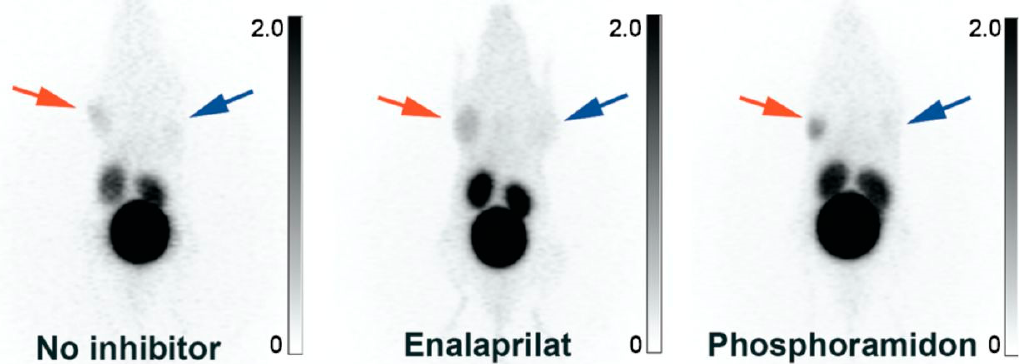
Figure 7. B1R positron emission tomography imaging. Maximum intensity projection PET images obtained with 68 Ga-P03083 without ( left ), with enalaprilat ( middle ), and with co-injection of phosphoramidon ( right ). The B1R + tumor (red arrow) was located on the right shoulder (the animal is viewed on a coronal projection, ventral viewpoint). The B1R − tumor (blue arrow) had no significant uptake. The gray scale bar to the right of each image is set in units of %ID / g. Figure reproduced from Lin, K.S.; et al. [77].